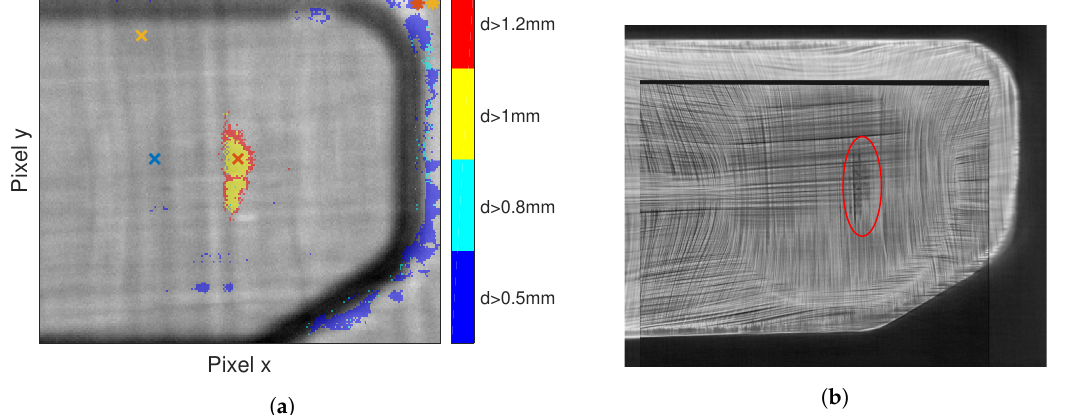
Figure 6. Comparison of active thermography with 3D-computed tomography: ( a ) results of the proposed algorithm and ( b ) the density map obtained by 3D-XCT at a depth of 1 mm from the front